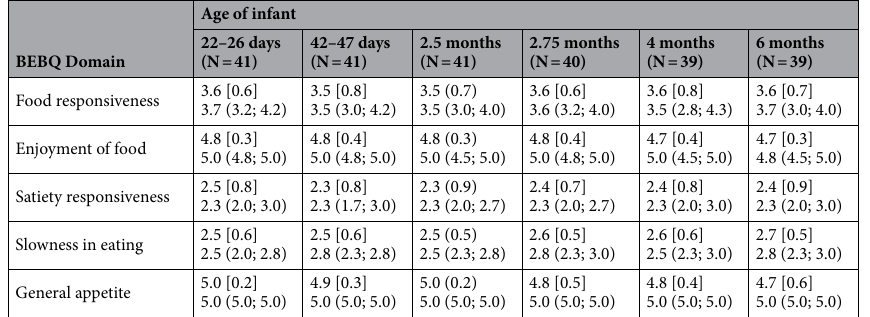
Table 2. Descriptive statistics for Baby Eating Behaviour Questionnaire (BEBQ) subscales by infant age (N = 41). Data shown as Mean [Standard Deviation]. Median (25th percentile; 75th percentile).